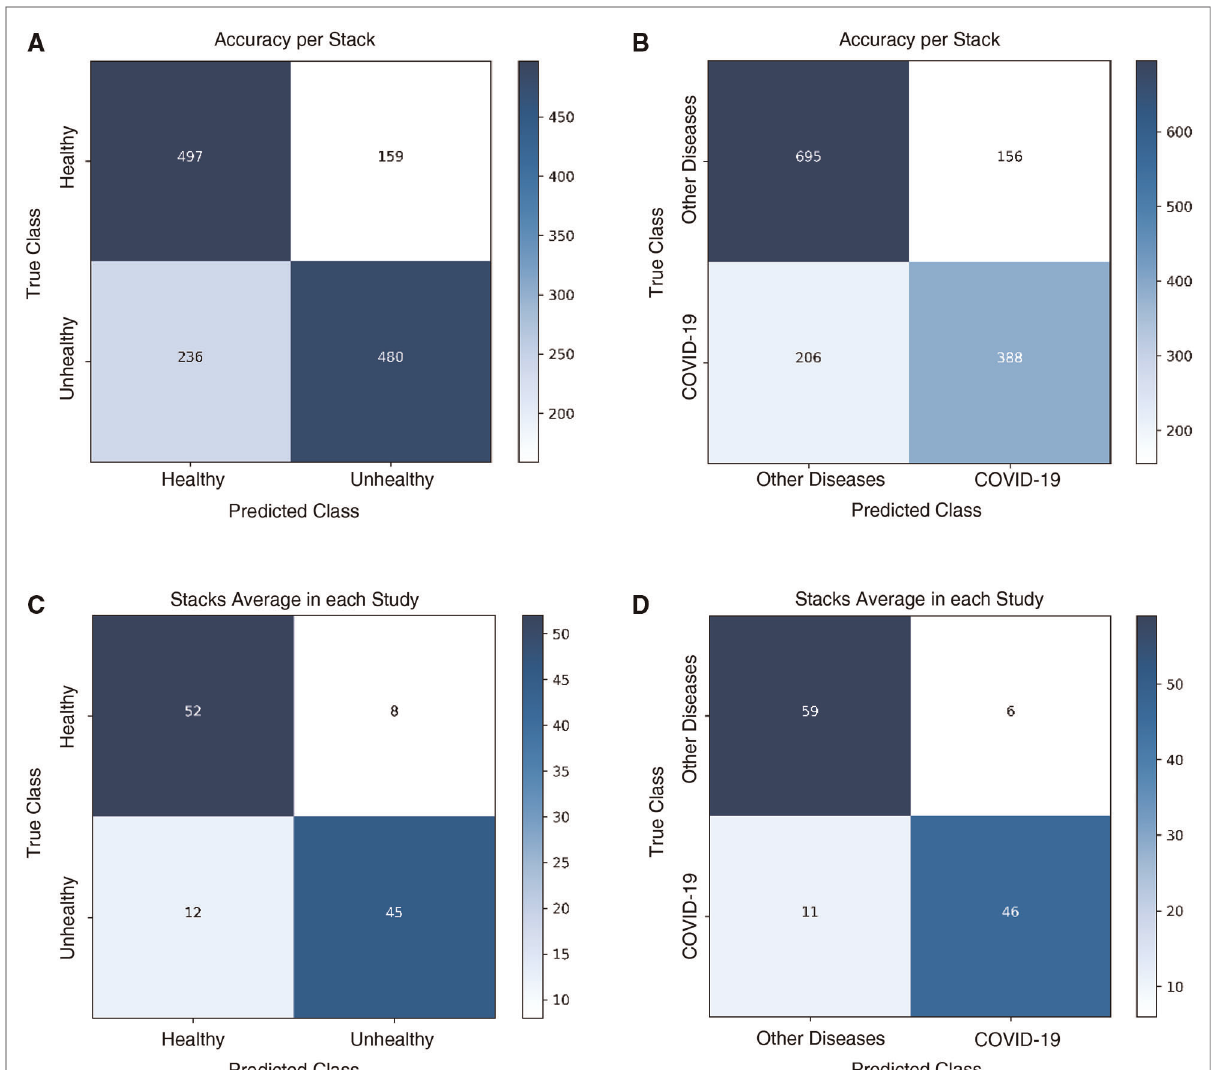
FIGURE 5 Classi fi cation results on the Colombian medical institutions test set. Confusion matrices for the ( A ) healthy vs. unhealthy classi fi er with the accuracy- per-stack metric, ( B ) other diseases vs. COVID-19 classi fi er with the accuracy-per-stack metric, ( C ) healthy vs. unhealthy classi fi er with the stacks- average metric, and ( D ) other diseases vs. COVID-19 classi fi er with the stacks-average